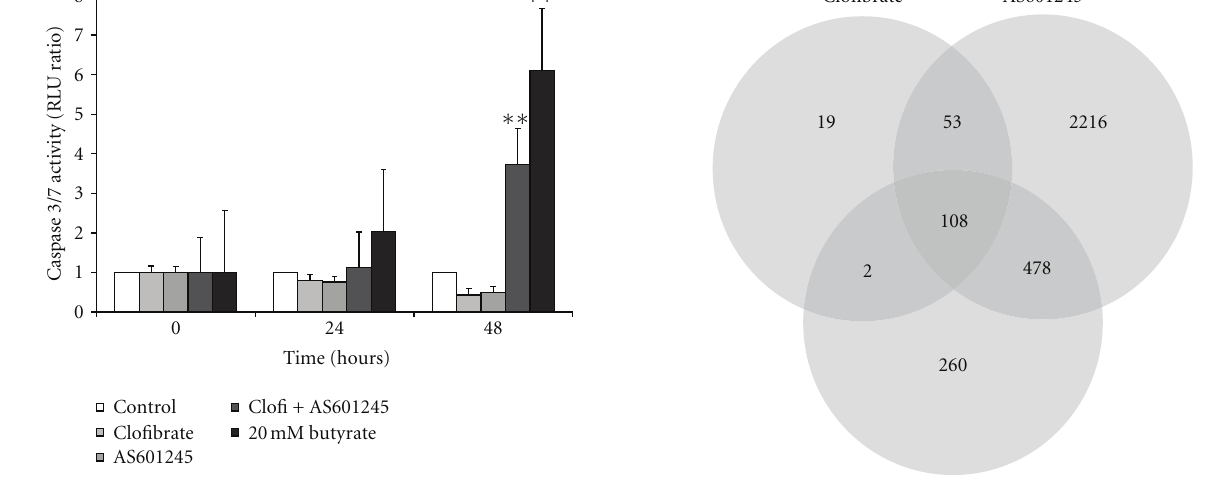
Figure 3: Induction of apoptosis. Induction of apoptosis in CaCo- 2 cells treated with 5 μ M clofibrate, 0.1 μ M AS601245, and the association of these two compounds (Clofi + AS601245). Apoptosis was evaluated at 0, 24, and 48 hours after the treatments, by measuring caspase 3/7 activity. 20 mM butyrate was used as a positive control. Results normalized to the respective control value for each experimental time is the mean ± SD of three separate experiments from three di ff erent preparations for each condition.